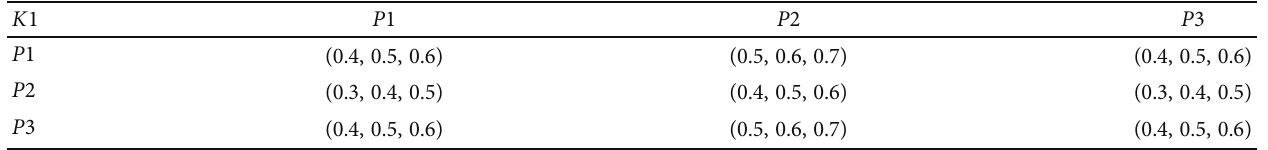
Table 6: Judgment matrix of personnel management risk indicators.